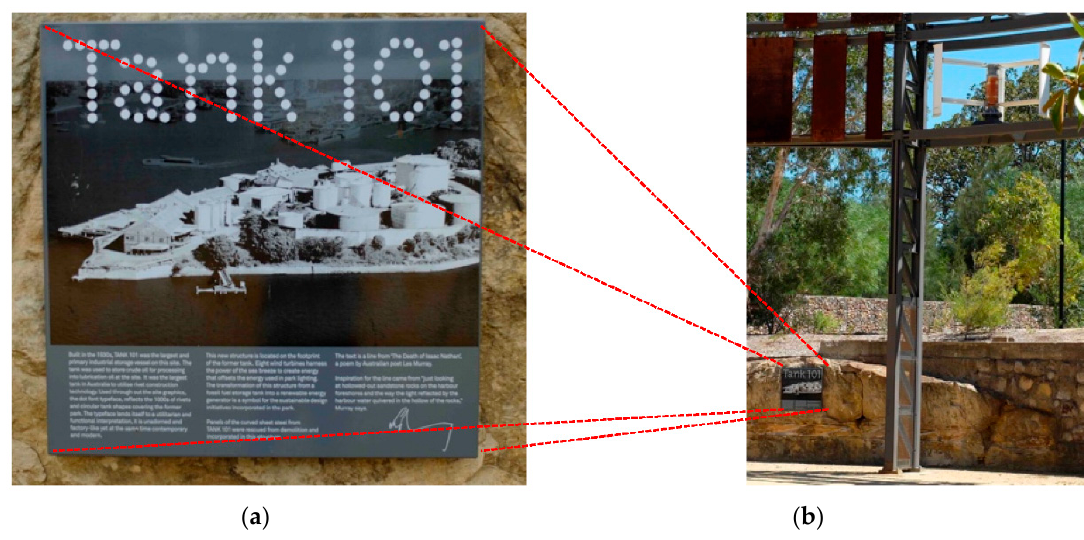
Figure 5. ( a ) The interpretive signage of renewable energy sculpture; ( b ) The renewable energy sculpture. Images by the author.